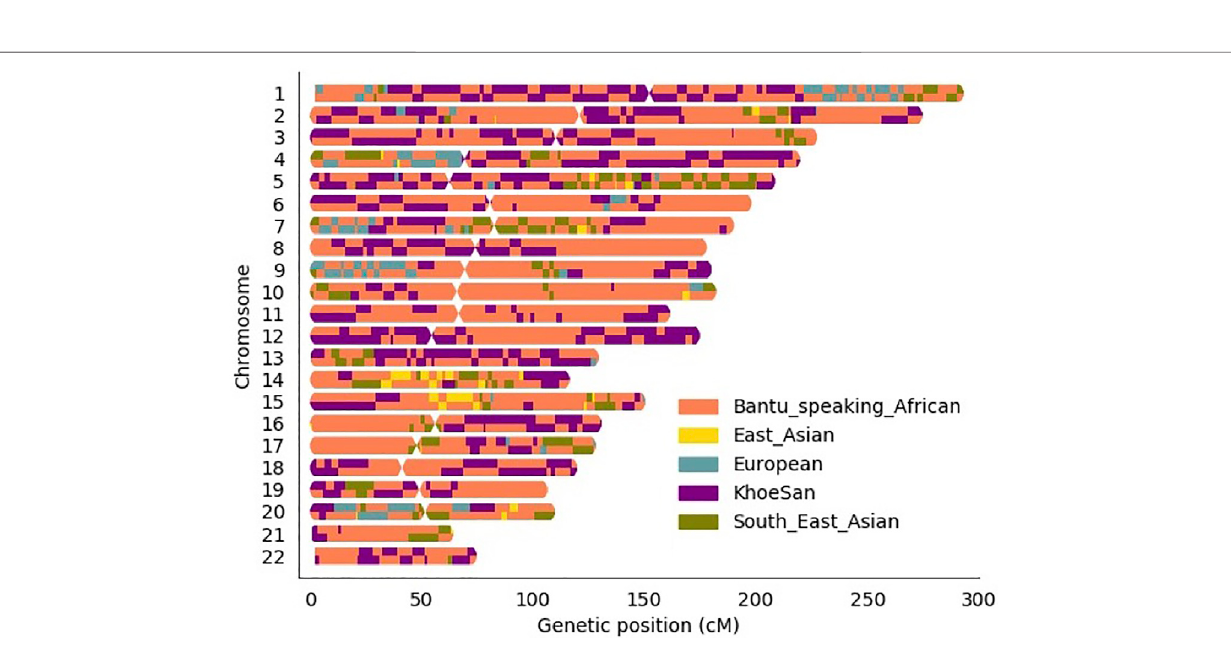
Table S4 . Only one ancestry (European) identi fi ed a local ancestry peak on chromosome 15 ( Supplementary Figure